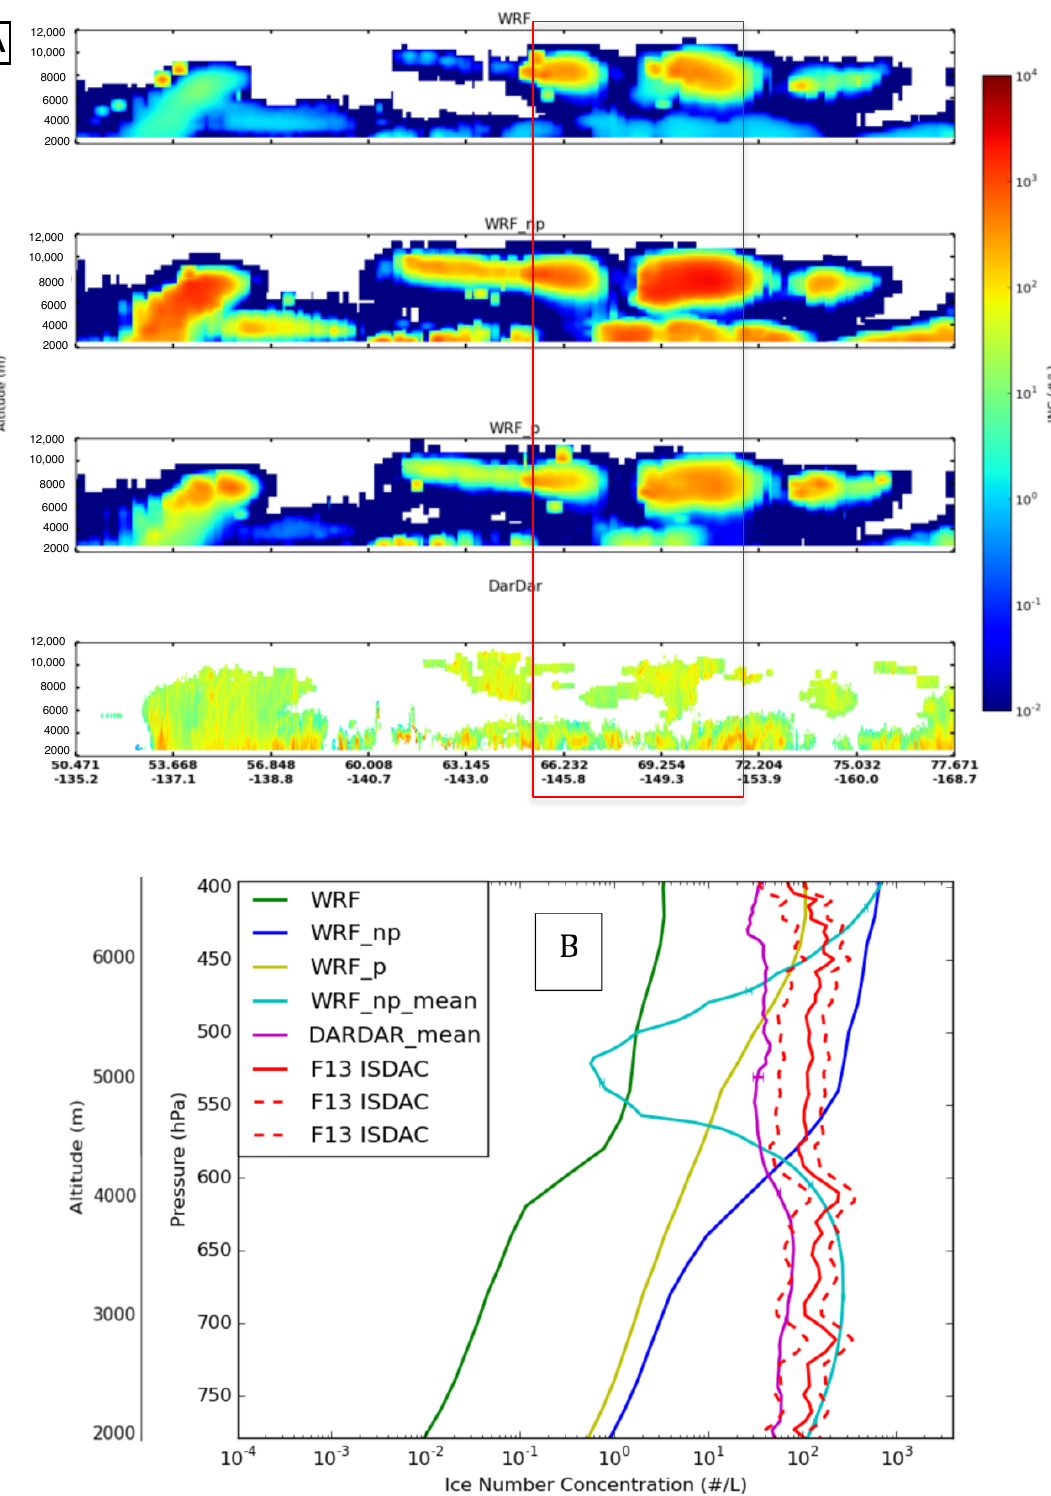
Figure 9. Observed and simulated (WRF, WRF_np and WRF_p) Ni along T13 track ( A ) and F13 flight ( B ). Simulated profile WRF_np_mean averaged along the satellite track over the larger domain of Figure 1 is also shown on ( B ) together with DARDAR-retrieved average profile. The dashed red line on ( B ) represents the variability (standard deviation) of ISDAC